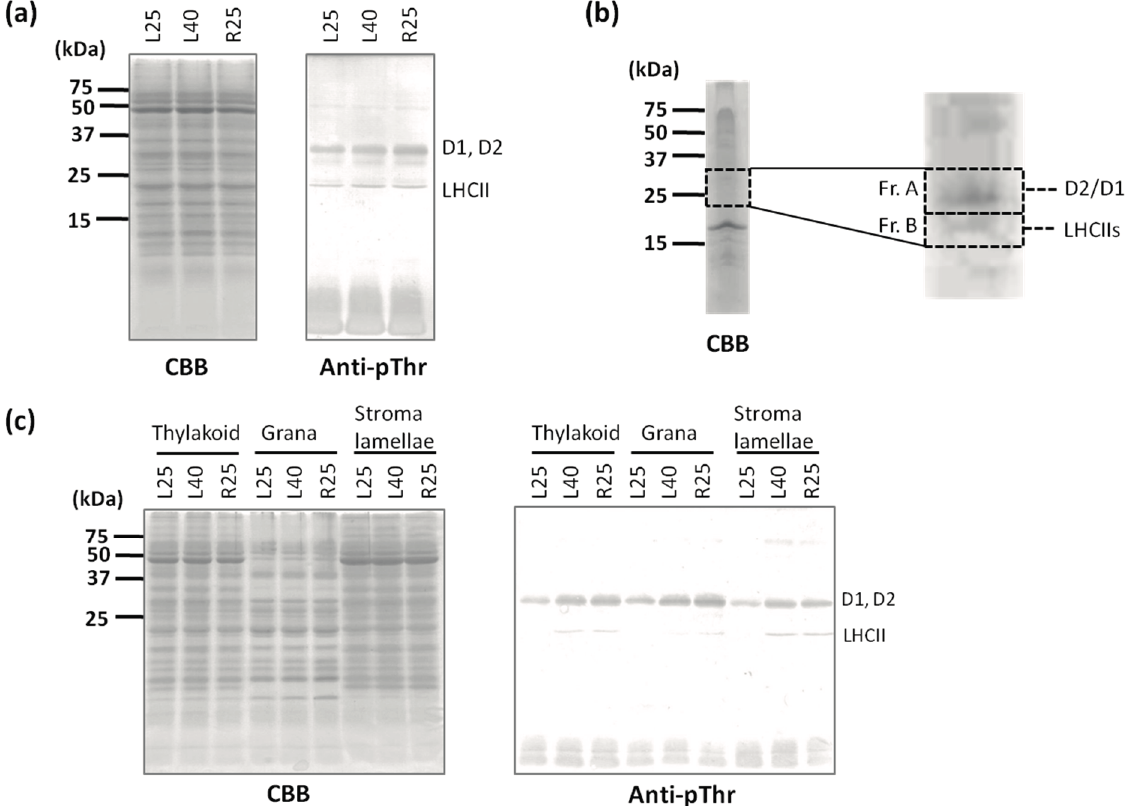
Figure 2. Phosphorylation level of PSII proteins increased by heat treatment. ( a ) Thylakoid membrane proteins were subjected to SDS-PAGE and subsequent immunoblotting using specific phospho-threonine antibodies; ( b ) Identification of the phosphorylated thylakoid proteins. Purified phosphorylated thylakoid proteins in L40 that were purified using the ProQ Diamond Phosphoprotein Enrichment Kit were separated by SDS-PAGE, and the bands in the dotted boxes were detected by peptide MS finger printing analysis. Mascot search results are shown in Supplemental Table S1; and ( c ) Thylakoid membrane proteins, immunoblotting using specific phospho-threonine